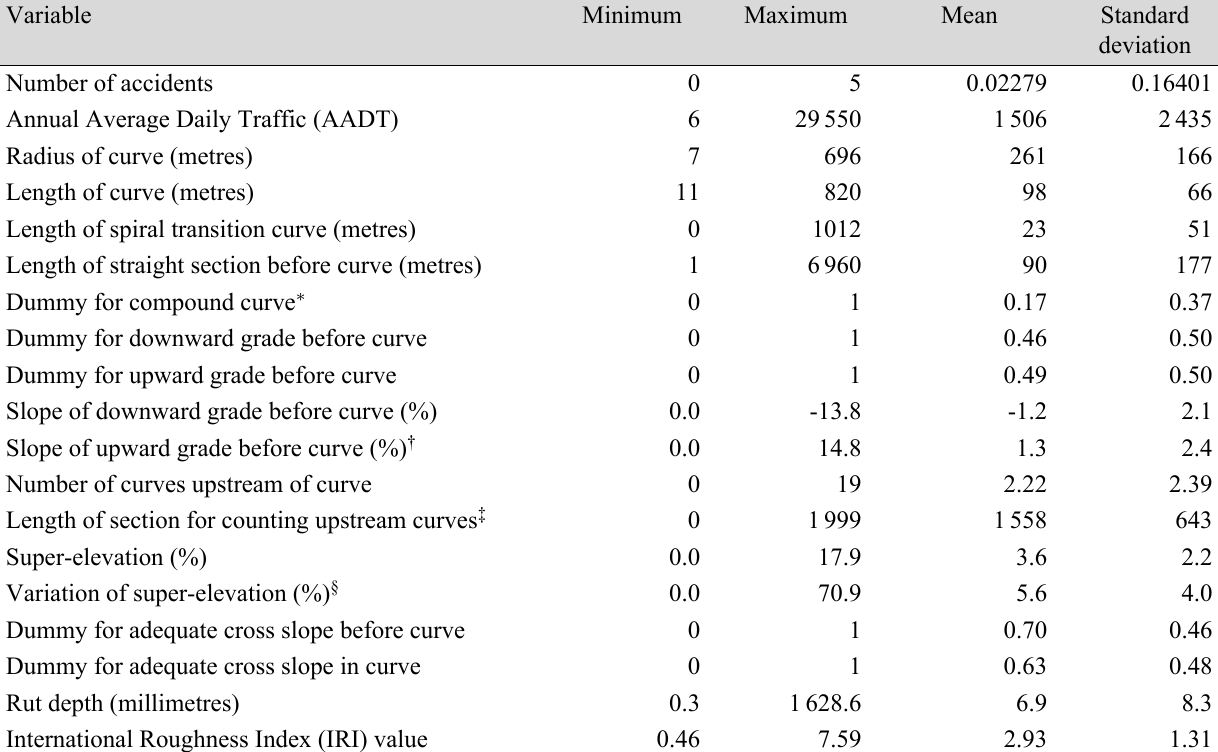
Table 2 Descriptive statistics for variables included in study